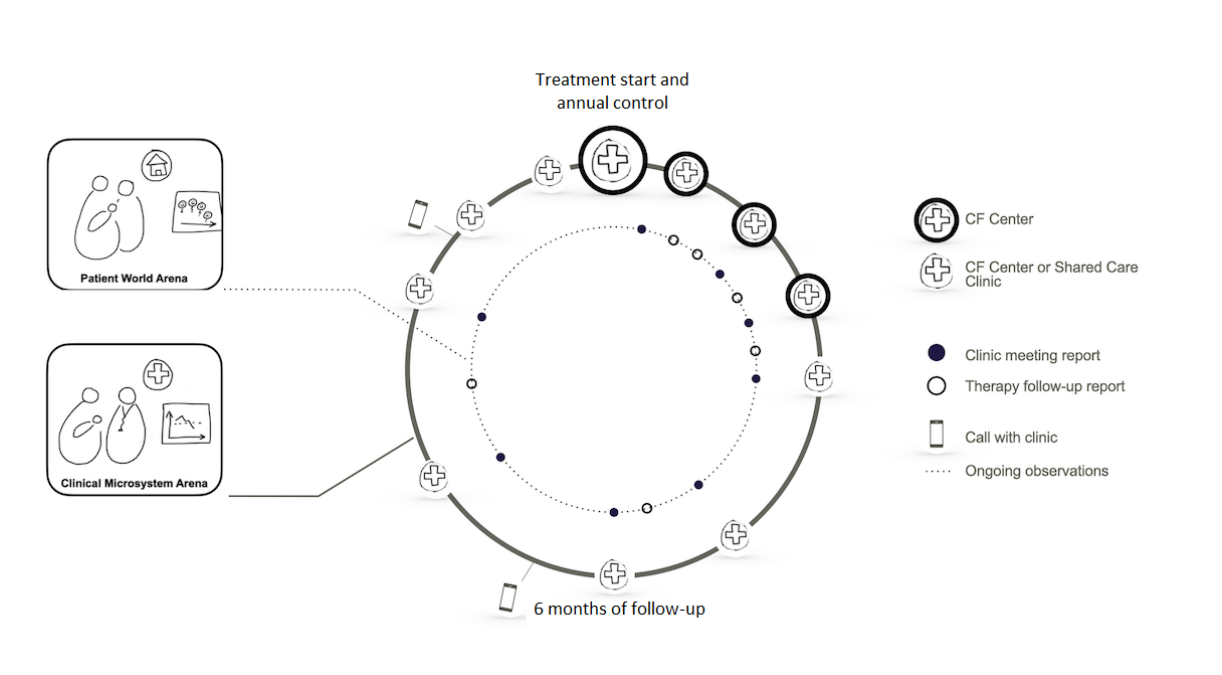
Figure 2. First-year customer journey with lumacaftor/ivacaftor therapy (an idealized flow with a new therapy linking the patient world and clinical microsystem